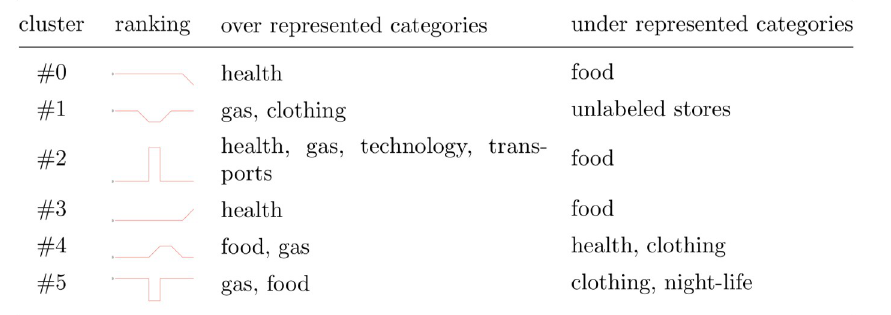
Fig 9. Summary of most important merchant categories found in each